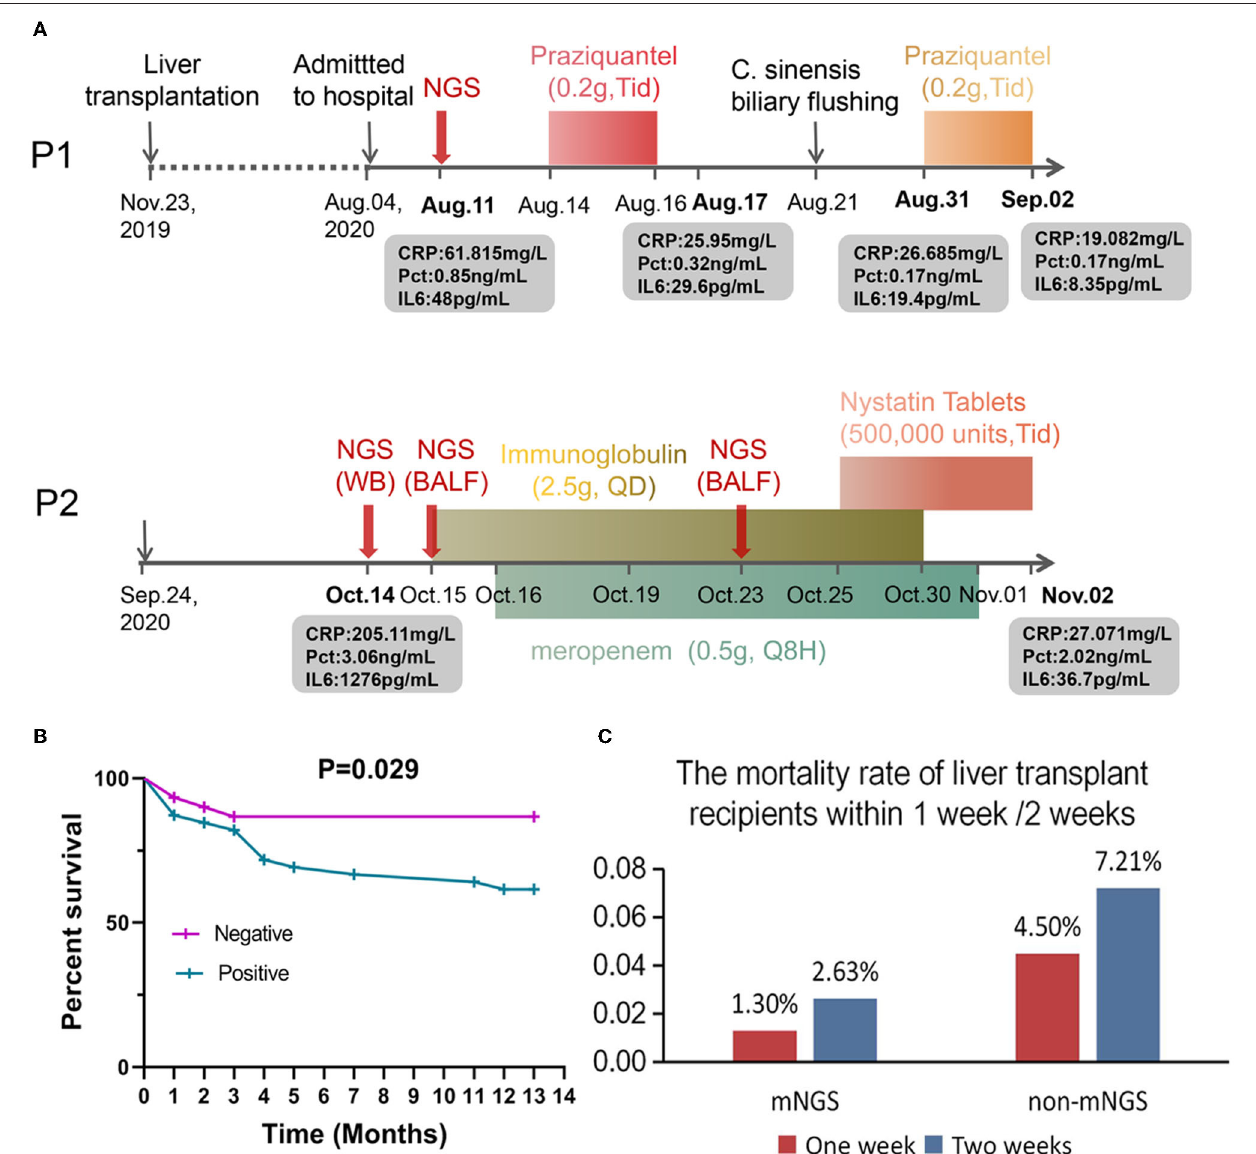
FIGURE 5 | Applications of clinical mNGS testing and prognosis of patients after liver transplantation. (A) Application of mNGS to diagnose infection after liver transplantation and adjustment of drug according to mNGS results improved the patient’s condition. (B) Analysis of mortality and survival in infected and uninfected patients. (C) The mortality rate of liver transplant recipients within 1 week /2